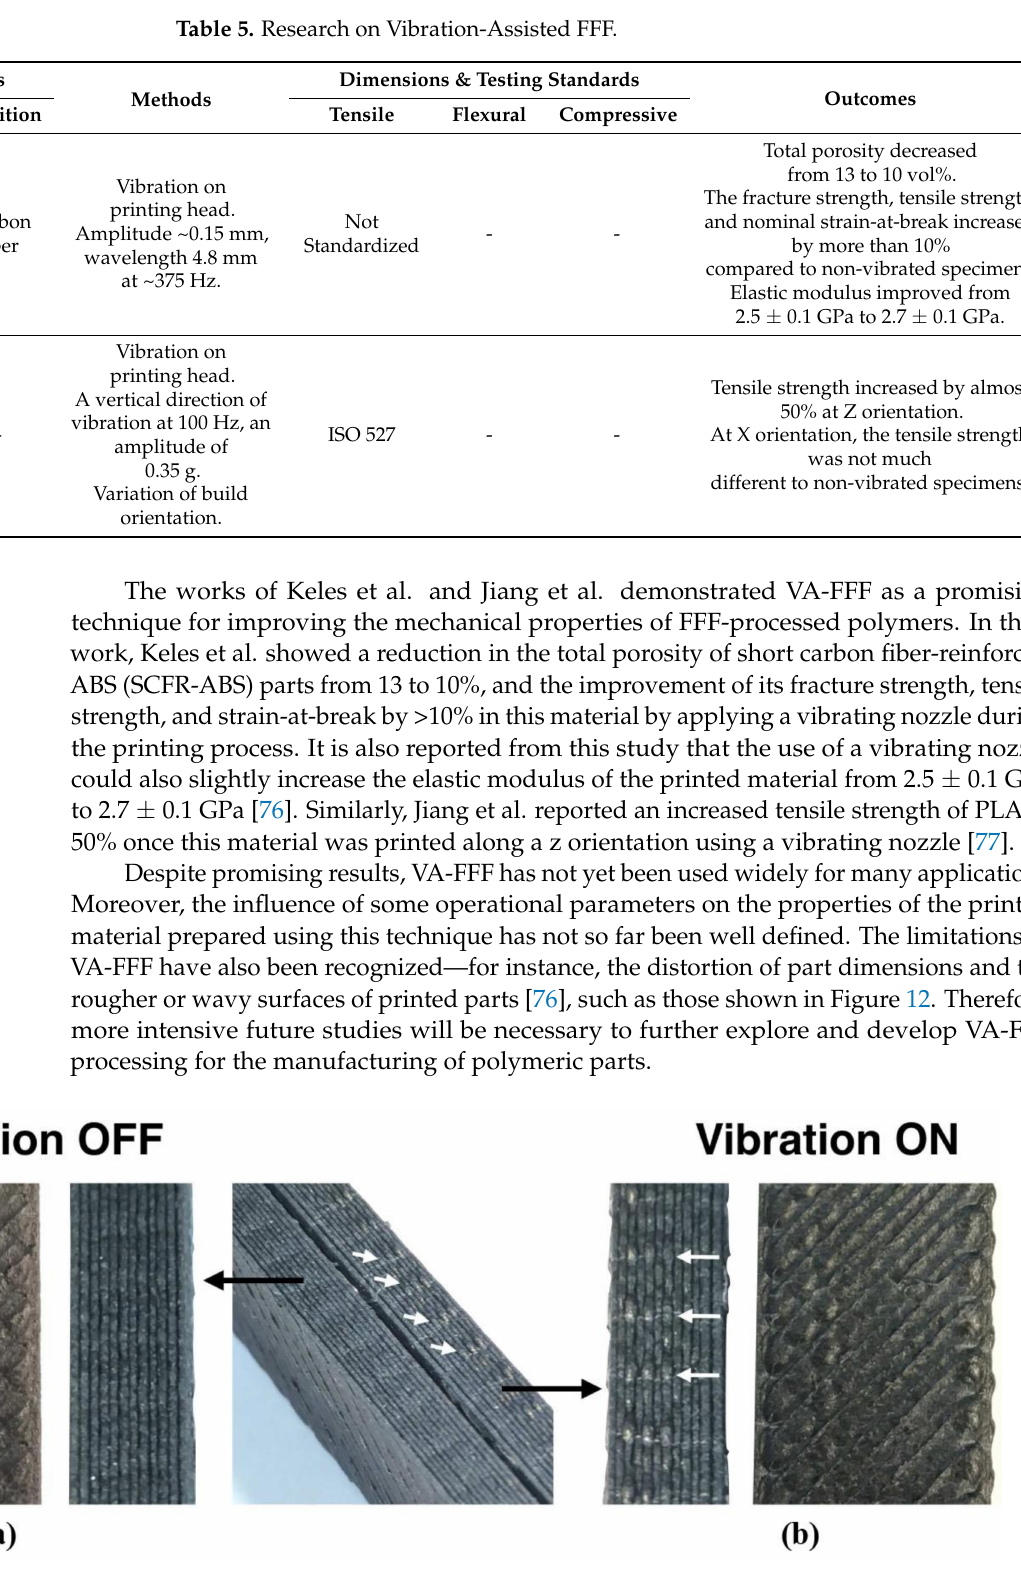
Figure 12. The surface of FFF-processed specimens: ( a ) without and ( b ) with vibrations. The white arrows in the figure show the crests of the vibration waves, resulting in waviness beyond the contour position. Reprinted with permission from [76]. Copyright 2018, Emerald Publishing